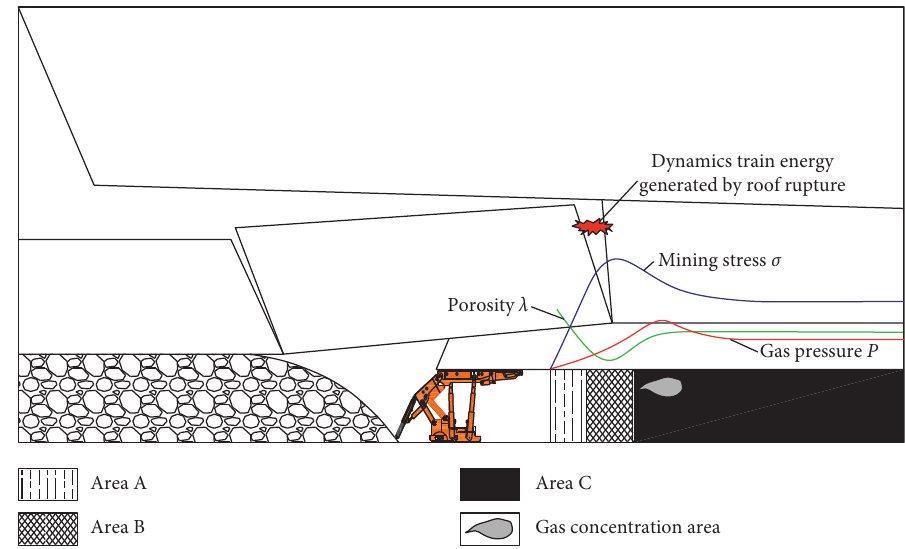
Figure 2: Coupling structural model of gas emission and stress in the working face.